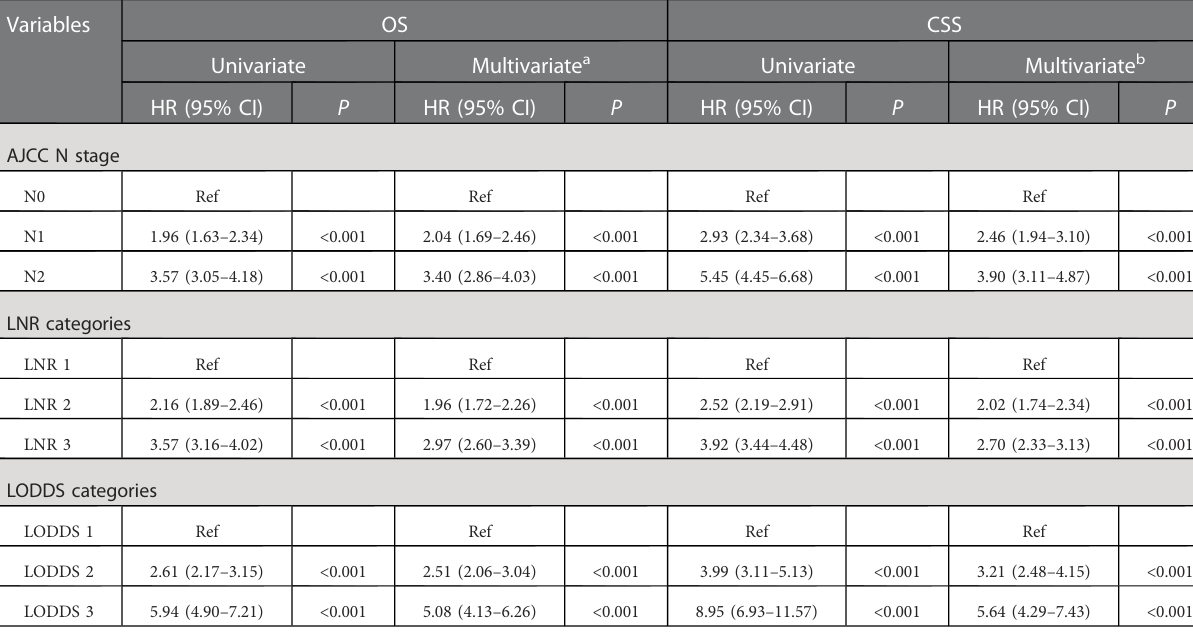
TABLE 2 Association of pN stage, LNR, and LODDS with OS and CSS in colorectal SRCC patients. Variables OS CSS Univariate Multivariate a